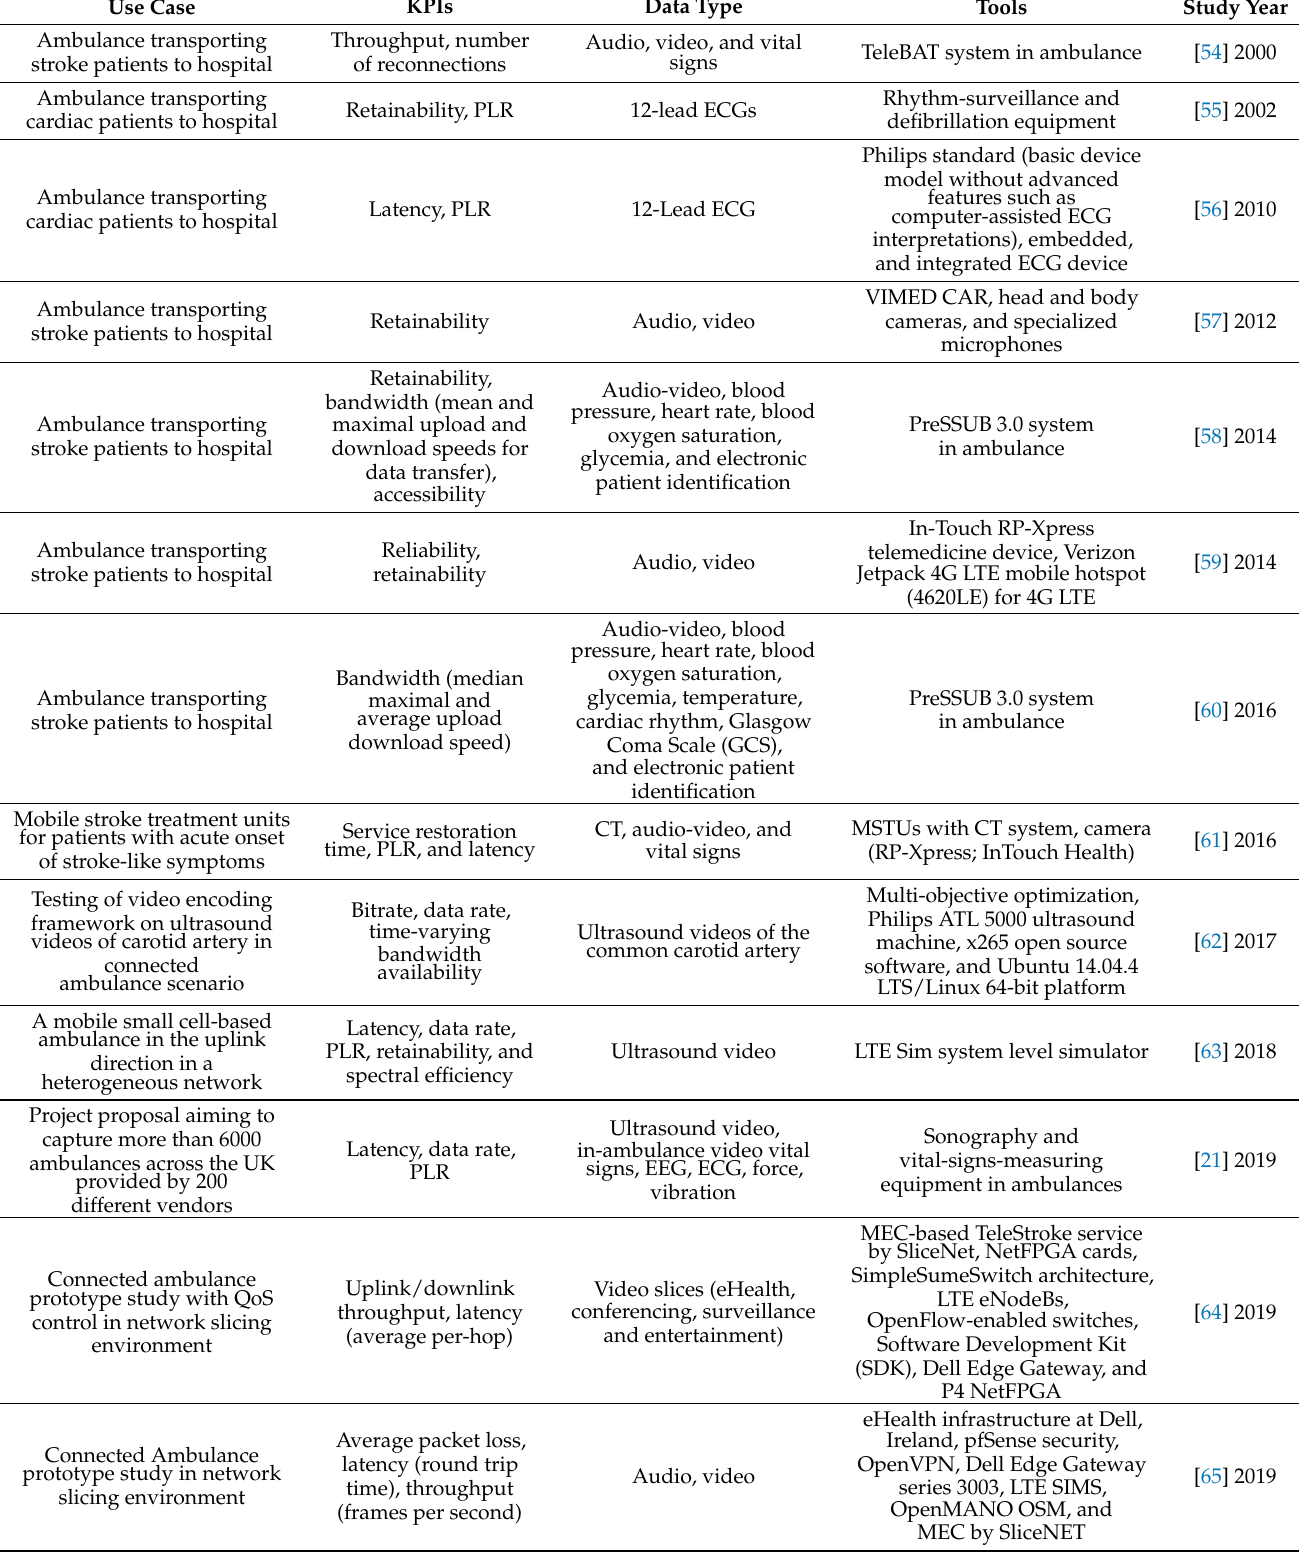
Table 1. Summary of literature for relevant connected ambulance